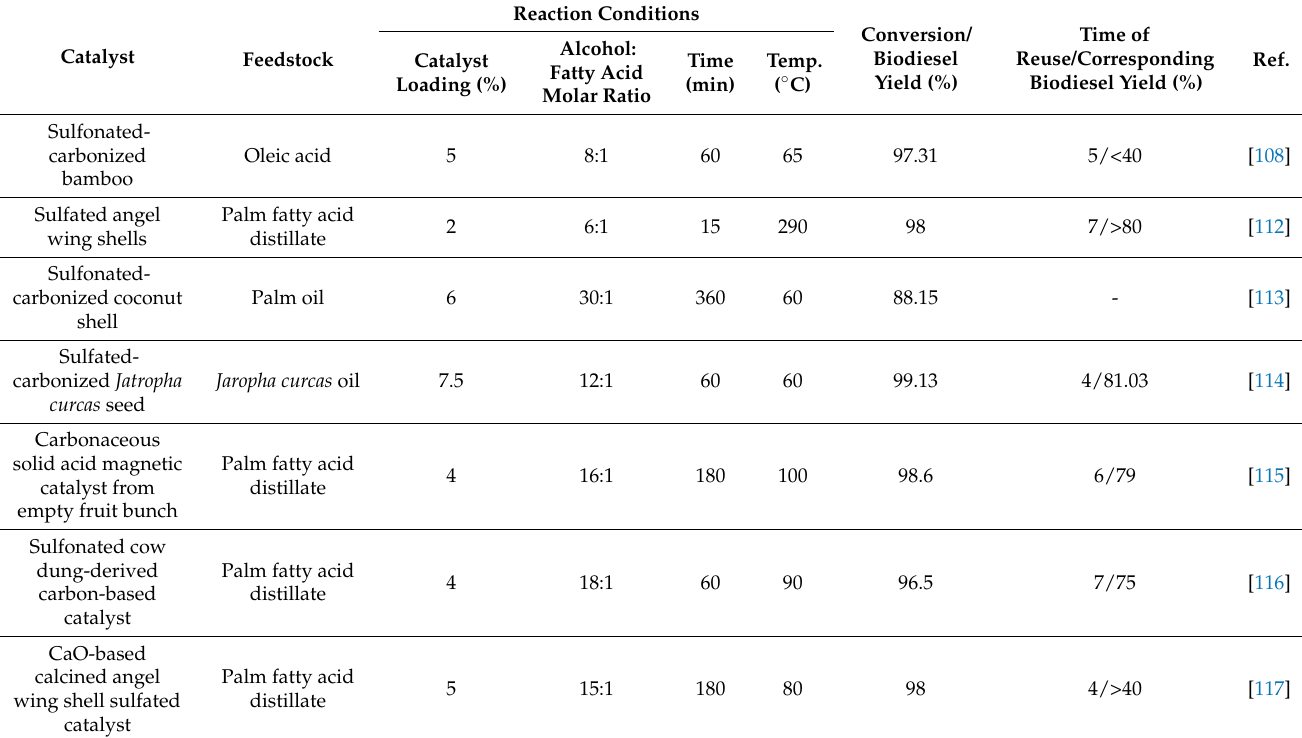
Table 2. Several bio-derived acid catalysts for biodiesel